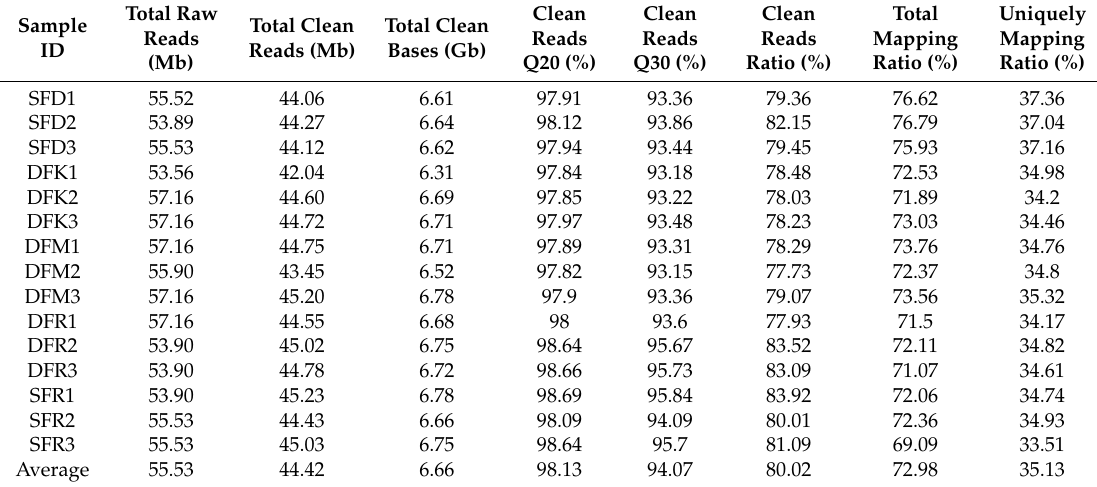
Table 1. An overview of sequencing and